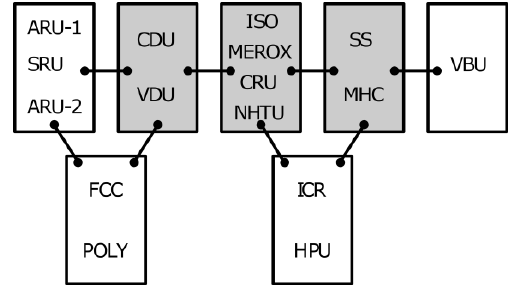
Figure 6. Graph illustrating allowed heat integration opportunities (indicated by edges between boxes) when direct heat integration is fully possible between all the units within the same area and heat integration is also possible between adjacent areas (case f).